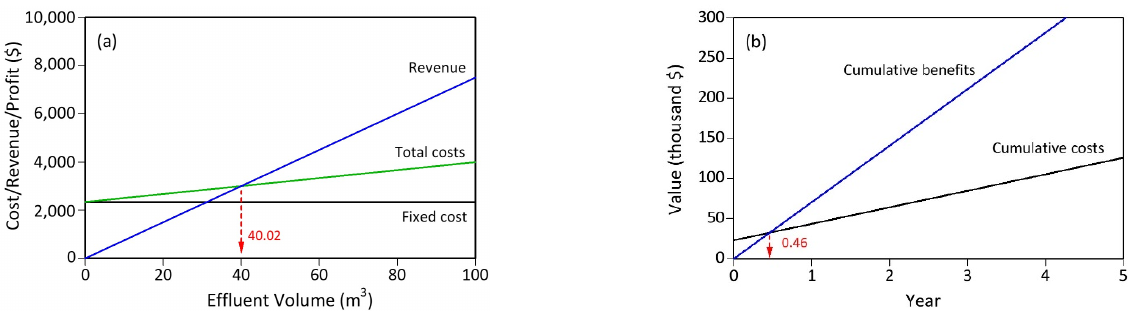
Figure 11. ( a ) Break-even analysis and ( b ) the payback period using the proposed plant maintenance system in 5 years of operation using TiO 2 /Na 2 Ti 6 O 13 composites.